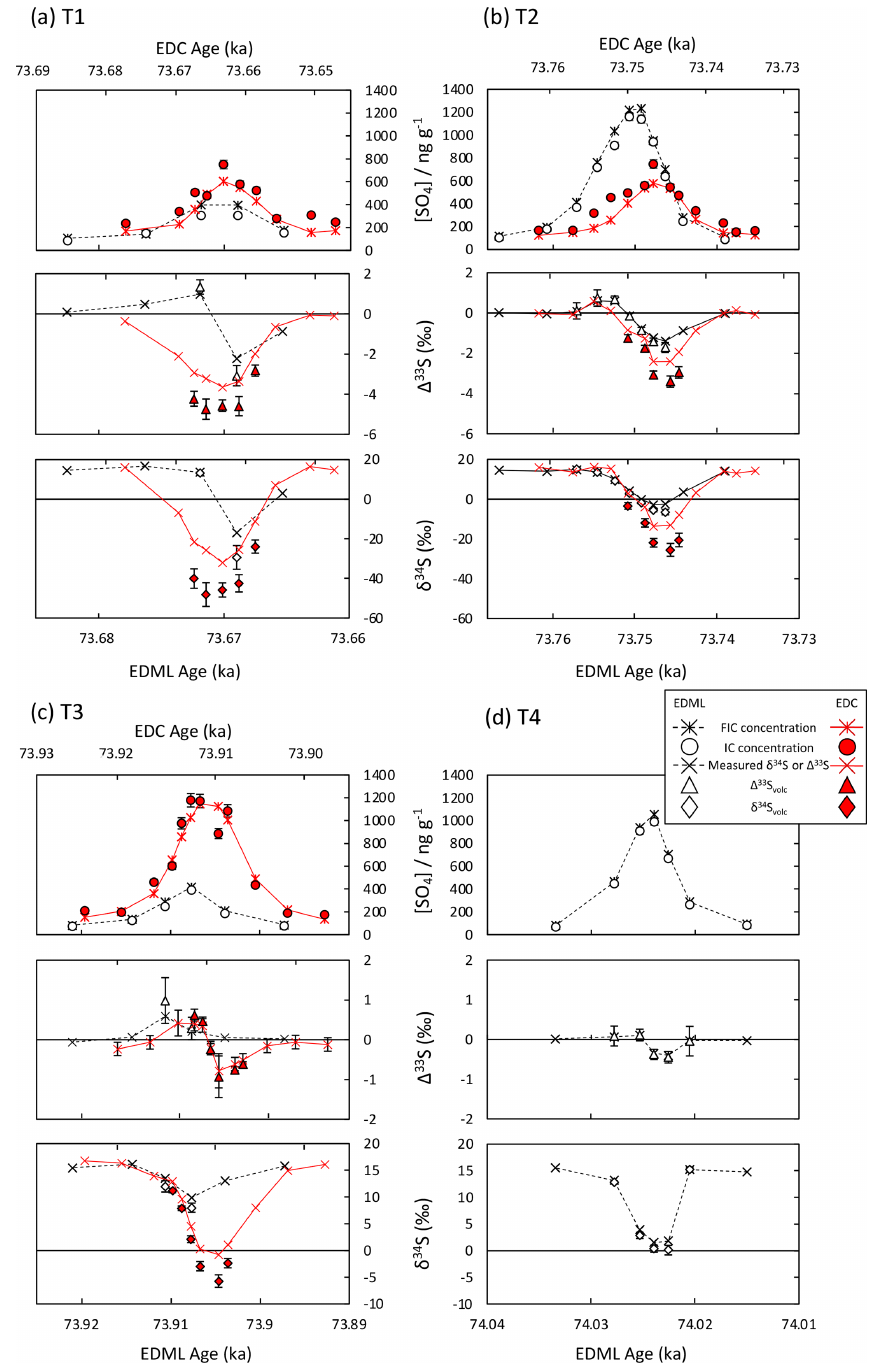
Figure 3. Sulfur isotopes in sulfate from T1, T2, T3, and T4 in both EDC (a–c) and EDML (all). Red lines and filled symbols are data from the EDC ice core, and black represents EDML. Both FIC (lines) and IC (points) data have been plotted for concentration. Lines on the isotope plots show measured values and symbols are background corrected data where f volc ≥ 0 . 65, as well as one point from T3 in EDML with f volc = 0 . 63. Error bars indicate 2 σ for measured ratios and 1 σ for background corrected ratios, where error bars are not visible the error is smaller than the symbol. Peaks have been aligned visually based on the isotope records, and this results in minor ( < 15 years) differences in the AICC2012 age model alignment between the two cores. Note the different scale for the isotopic data in (c) and (d) compared to (a) and (b)